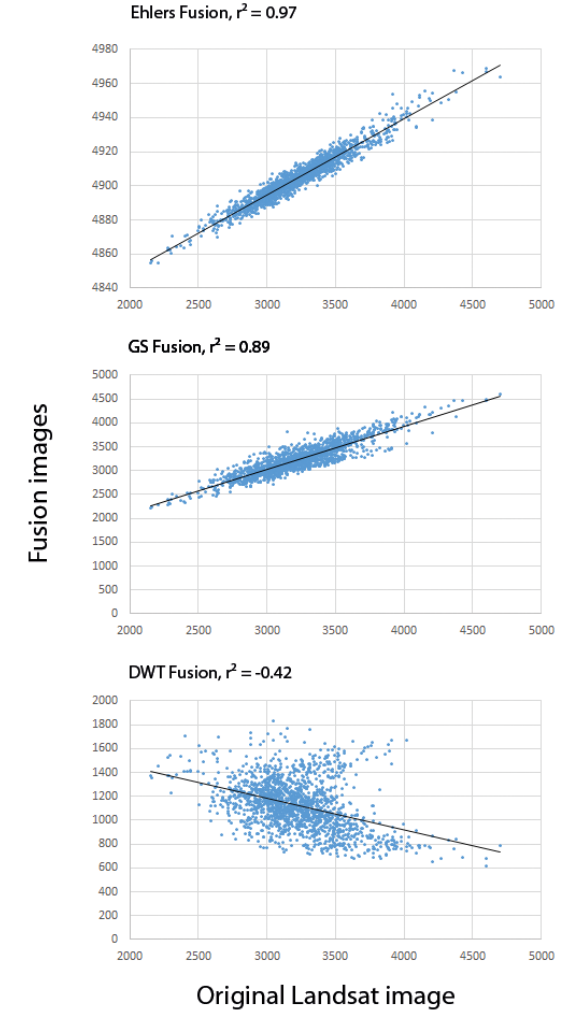
Figure 4. Scatter plots and correlation coefficients for three image fusion results referring to the original image. The Ehlers fusion method yields the highest r² score.